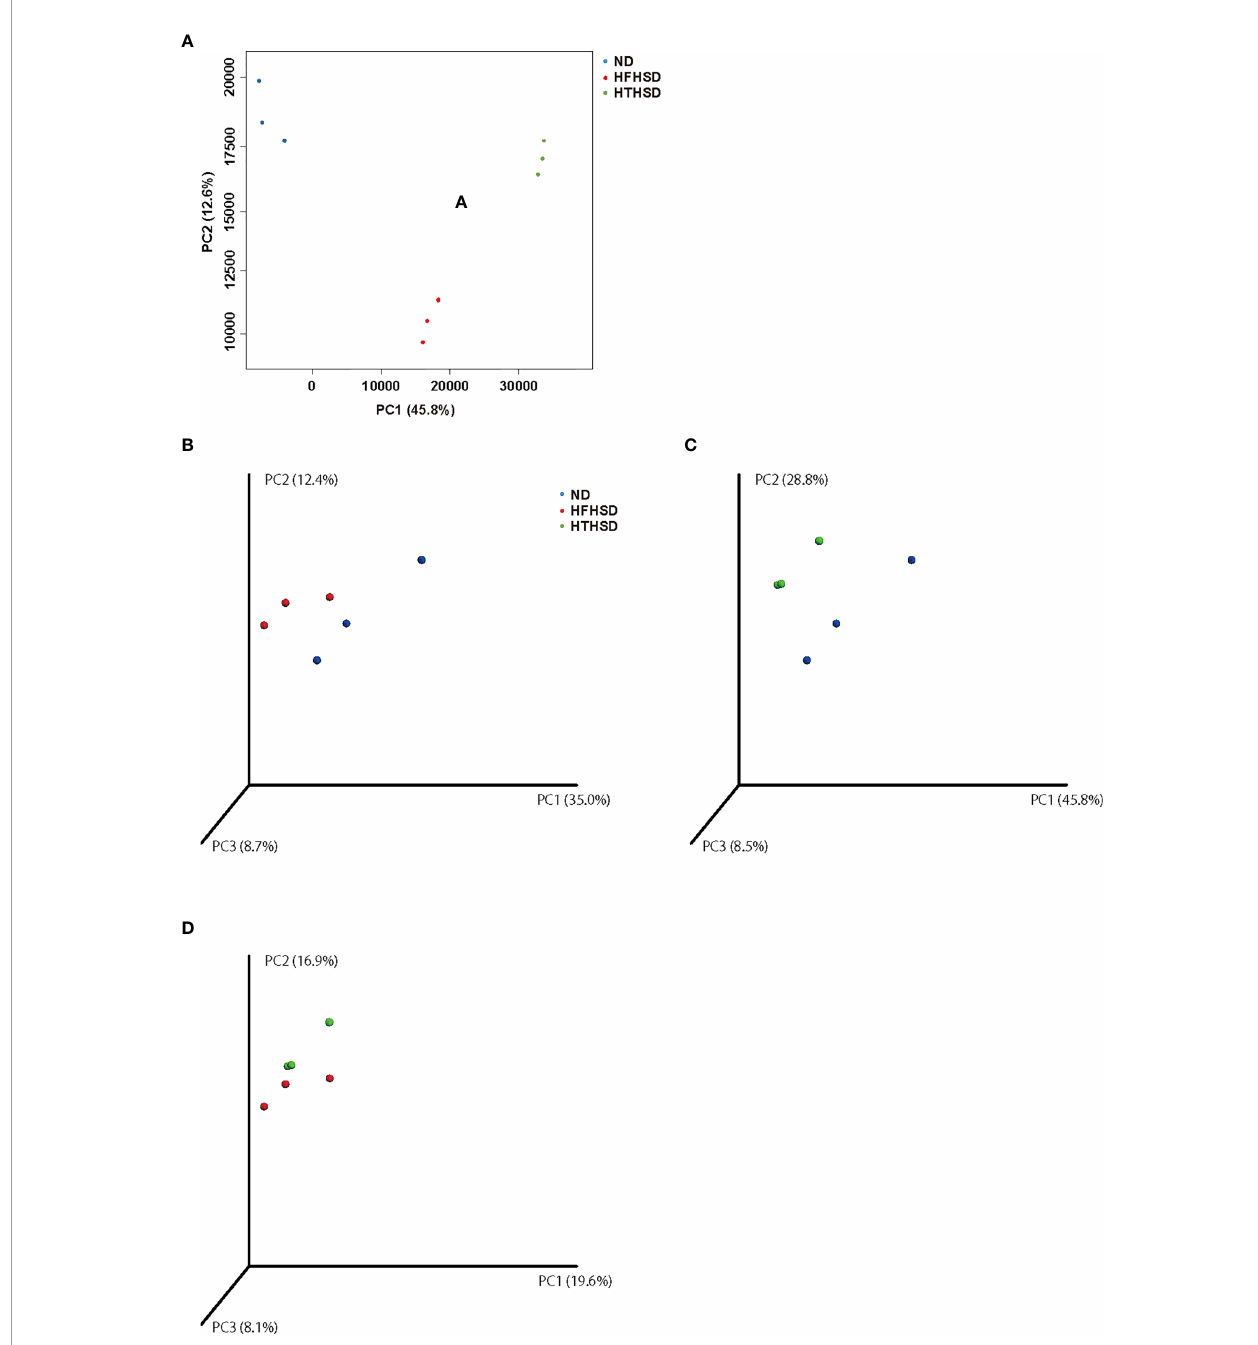
FIGURE 5 | PCoA plots of gut microbiota of mice fed with ND, HFHSD, or HTHSD (A) Weighted PCoA plots were shown (n=3). Weighted beta-diversity with PERMANOVA test were shown (n=3). (B) ND vs HFHSD (p= 0.010), (C) ND vs HTHSD (p= 0.007), and (D) HFHSD vs HTHSD (p= 0.055). PCoA: Principal coordinate analysis, PERMANOVA: Permutational multivariat analysis of